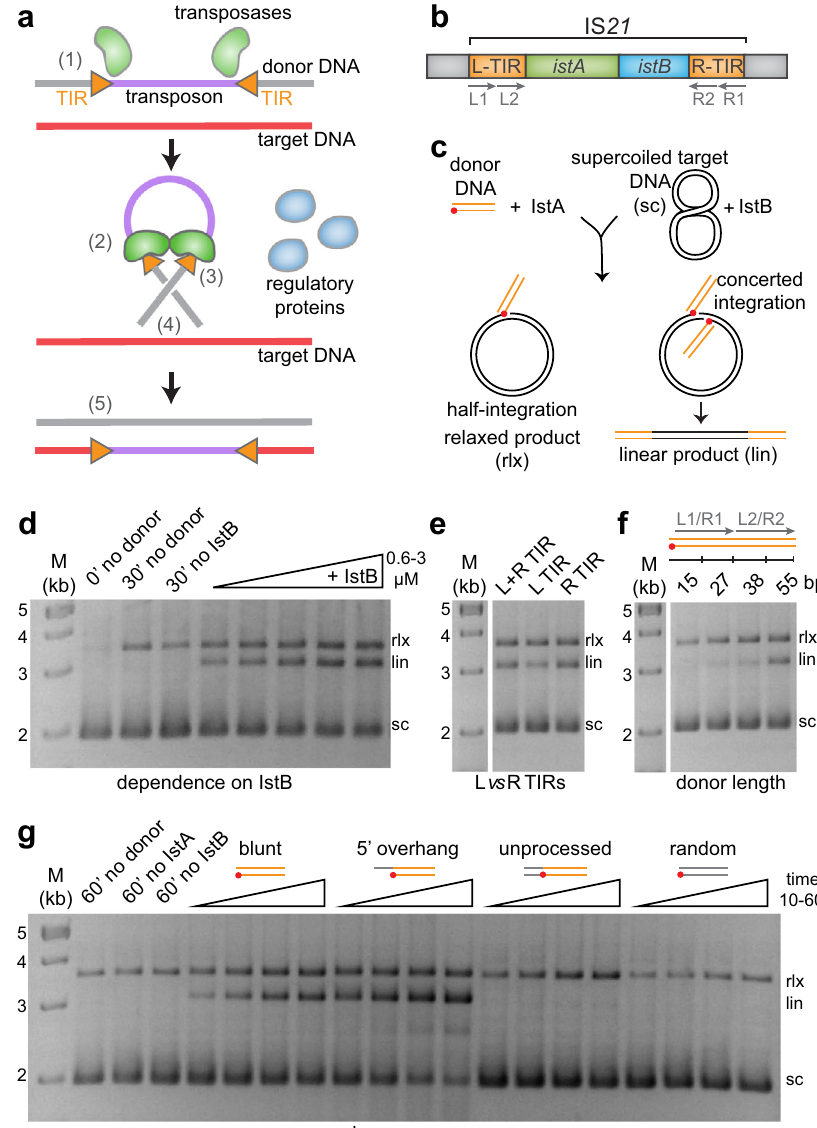
Fig. 1 | IS 21 transposon organization and characterization of the DNA inte- grationreaction.a Simpli fi edschematicofthetranspositionreaction.TIRterminal inverted repeats.Numbersindicate someofthesteps of the transpositionreaction described in the main text. b Genetic organization of prototypical IS 21 members, including IS 5376 . The left and right TIRs (L-TIR and R-TIR) are composed of two multiplerepeats(L1/L2andR1/R2). c Schematicofaninvitrointegrationassay.Pre- cleaveddonorDNAshowninorangeandtargetplasmidinblack.Reddotindicates the position of the terminal CA dinucleotide that contains the donor 3 ’ -OH. d Integration of the transposon ends performed in the absence and presence of variable IstB concentrations (equimolar mixture of pre-cleaved L an R ends). Molecular weight marker (in kb) indicated as M. Nucleic acid products labeled throughout the fi gures as supercoiled (sc), linear (lin) and relaxed (rlx) DNAs. This